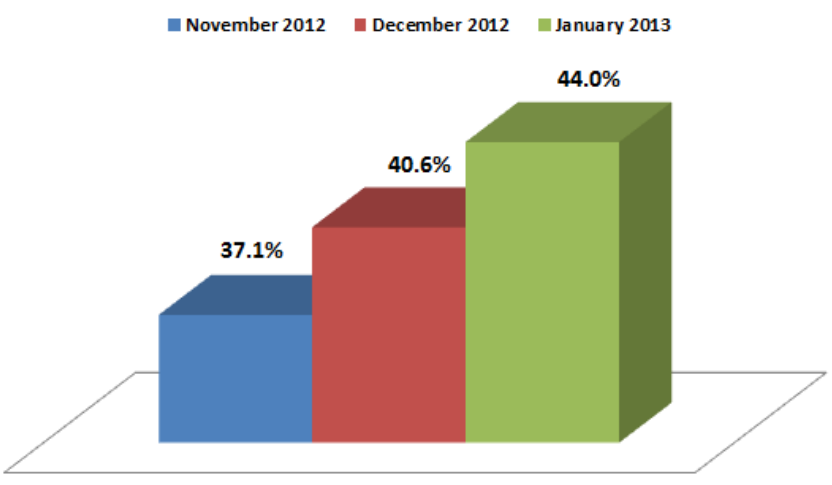
Figure 12. Percentage of energy consumption involved in thermal